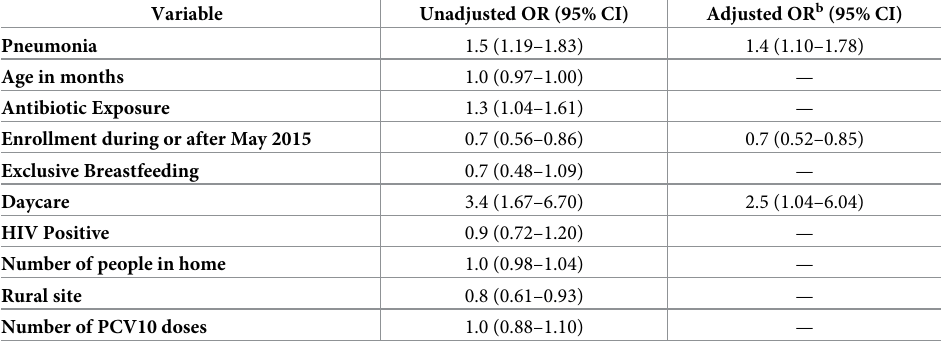
Number of PCV10 doses — a Serotypes in the PCV10 vaccine including those that PCR is not able to distinguish b Candidate variables for the model included age, antibiotic exposure, exclusive breastfeeding, site, number of people